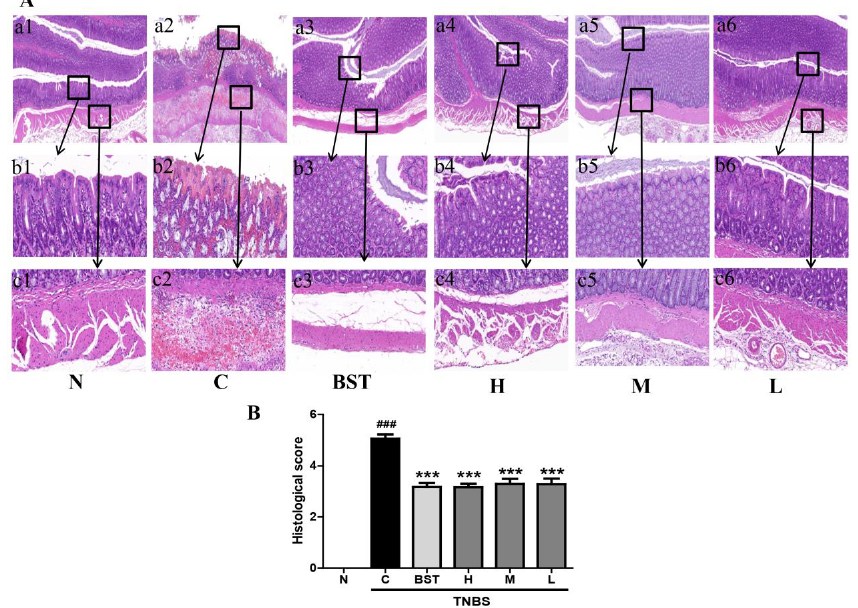
Figure 2. CAL suppresses histological injury in TNBS-induced colitis in rats. ( A ) Representative images of hematoxylin and eosin (H&E) staining of colon tissue from different groups (a1 – a6). Scale bar = 100 μ m. The area within the rectangle in each picture is enlarged and presented below, correspondingly, displaying the mucosa (b1 – b6) and submucosa (c1 – c6) in each group. Scale bar = 10 µ m. ( B ) Colonic histological score. N: normal group; C: TNBS only group; BST: balsalazide 1 g/kg + TNBS group; H: CAL 500 mg/kg + TNBS group; M: CAL 250 mg/kg + TNBS group; L: CAL 125 mg/kg + TNBS group; n = 8, ### p < 0.001 vs. normal group; *** p < 0.001 vs . TNBS group. Data (mean ± standard error of the mean (SEM)) were analyzed by